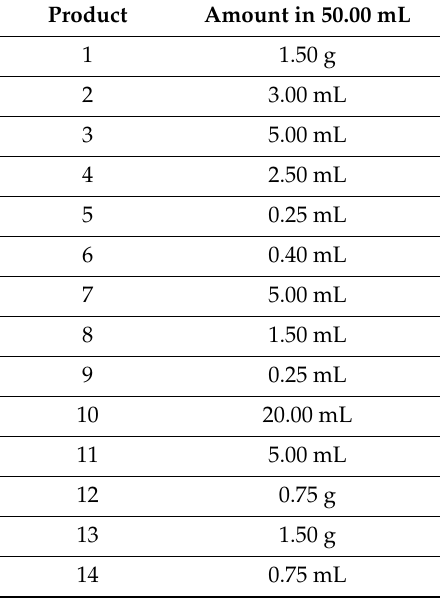
Table 3. Product amount used for inductive coupled plasma optical emission spectrometry (ICP-OES) sample preparation in a final volume of 50.00